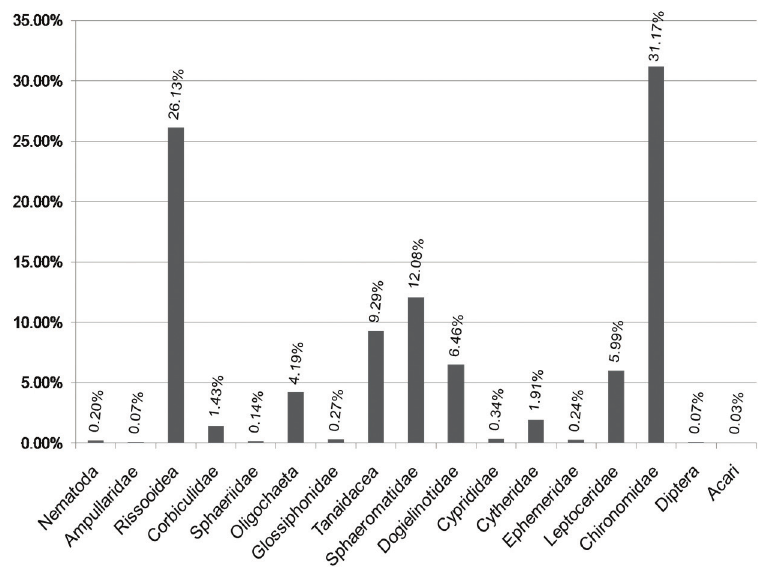
Figure 2. Relative abundance of benthic macroinvertebrate taxa in Lake Figueira in all